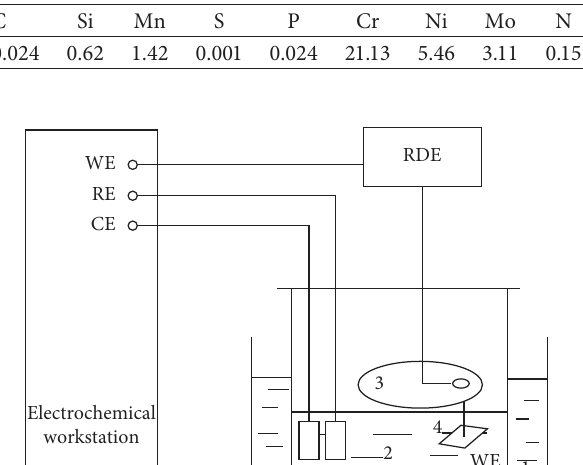
Table 1: Chemical composition of 2205 DSS specimens (wt. %).